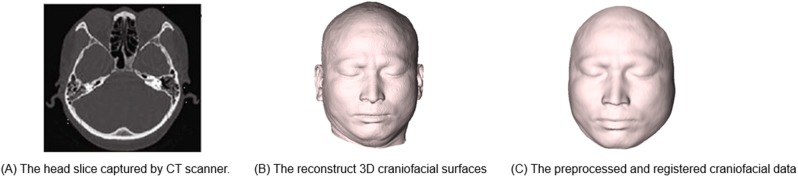
The procedure of craniofacial data acquisition.